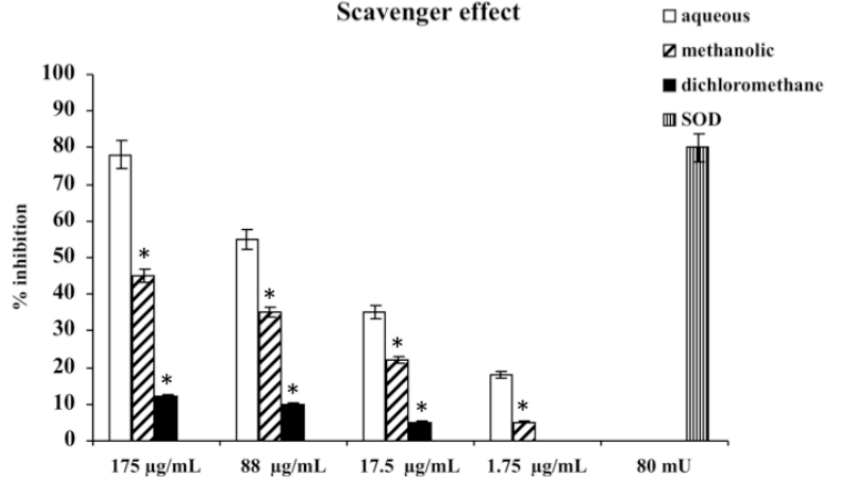
Figure 1. Scavenger effect of extracts of M. foetida Schumach. et Thonn. on superoxide anion; results are expressed as percentage of inhibition of NADH oxidation (rate of superoxide anion production was 4 nmol/min). Each value represents the mean ± SD of five experimental determinations. * p < 0.001 vs. the same concentration of the aqueous extract.